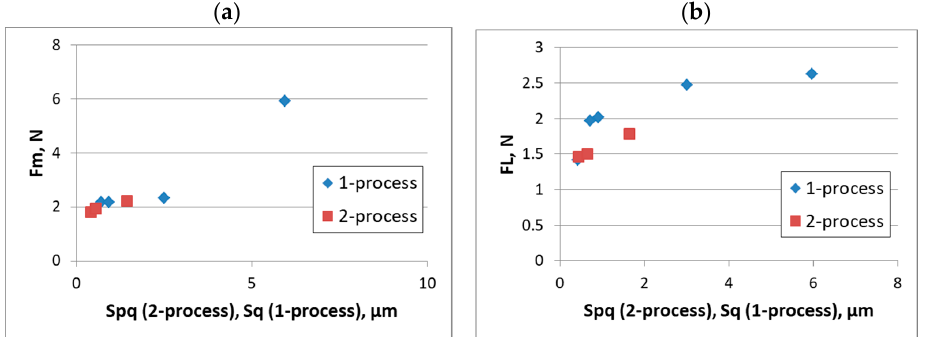
Figure 24. Dependence between the Sq parameter of the one-process random surface and the Spq parameter of the two-process random surface and the maximum friction force Fm ( a ) and the final friction force ( b ) adapted from [197].